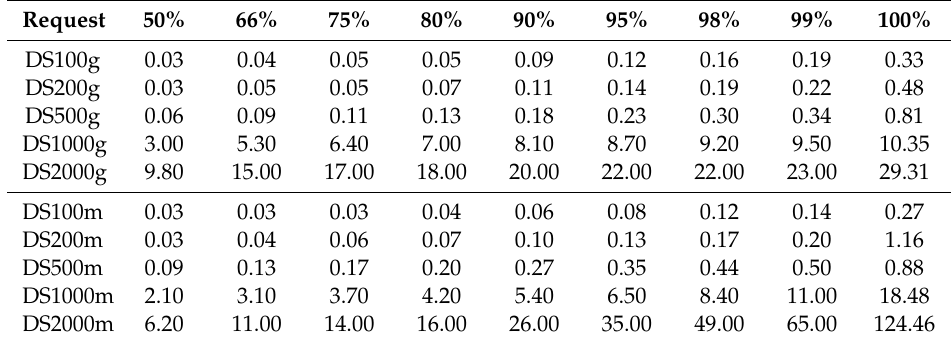
Table 9. Percentage of describeSensor requests completed within given times (in seconds) for the di ff erent configuration of concurrent users and WSGI server (case